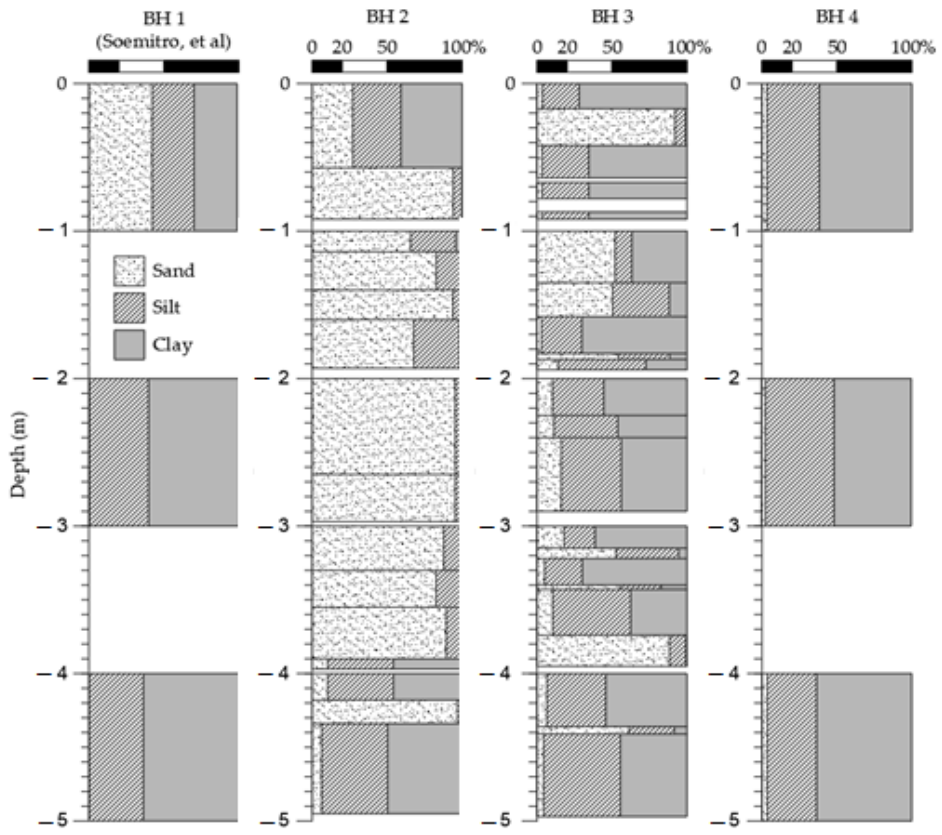
Figure 12. Stratigraphy of sediment grain distribution.